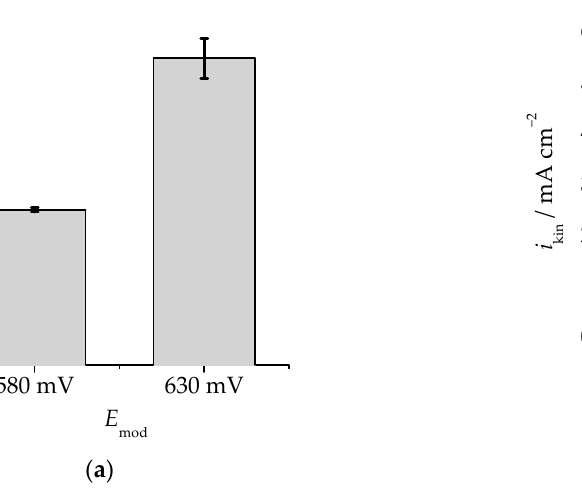
Figure 7. The effect of the potential ( a ) and the electric charge ( b ) of selective dissolution of the Cu 85 Pd 15 alloy on the rate of the kinetic phase of electro-oxidation of formic acid. ( a )—The imposed charge was constant, q mod = 24 mC·cm − 2 ; ( b )—the anodic potential was constant, E mod = 630 mV.